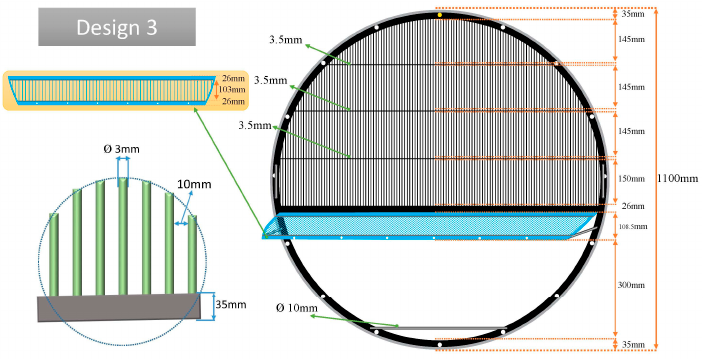
Figure 4. Third JTED sorter design for Taiwanese bottom trawlers with single boat bottom otter trawls.